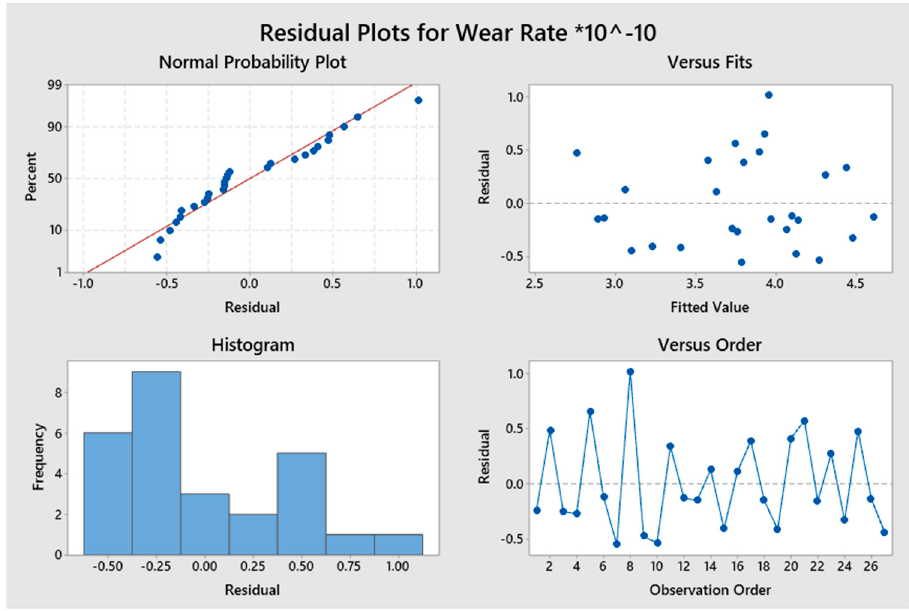
Figure 9. Residual plot for the wear rate for varying